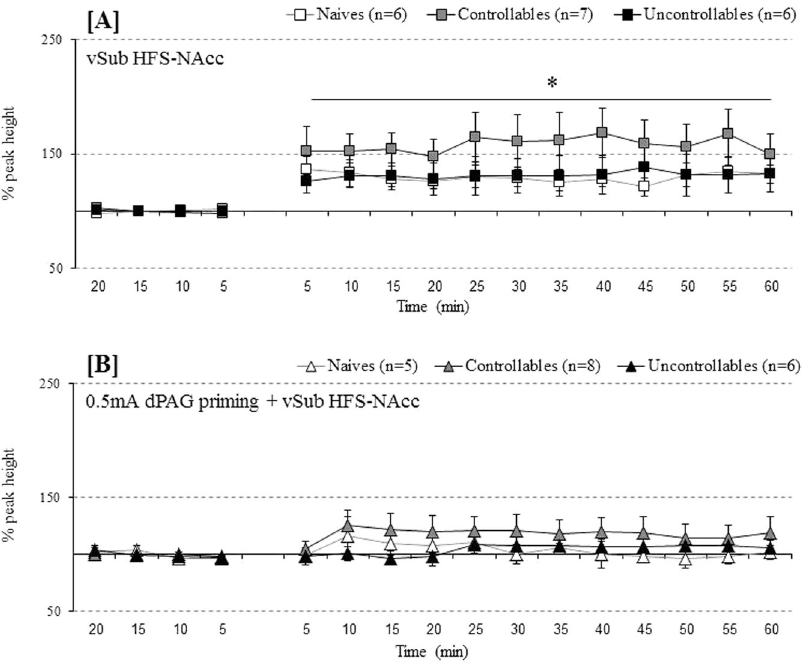
compared to baseline); ( B ) Applying vSub HFS + 0.5 mA priming block the previously induced plasticity in the all groups (i.e. naïve, controllable and uncontrollable rats; n.s